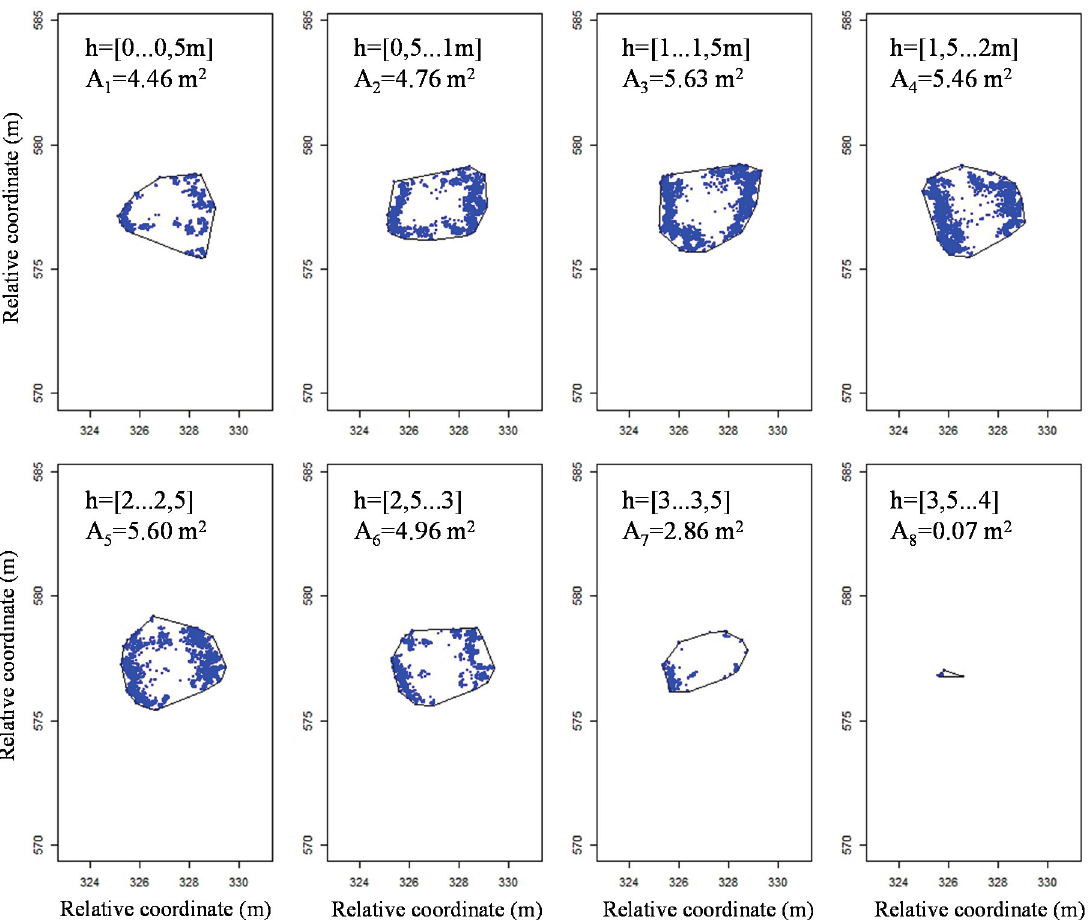
Figure 7. Projections of the points inside the different slices for a height interval of 0.5